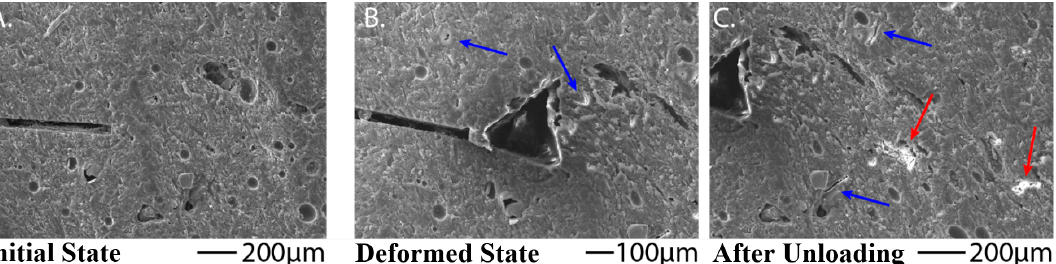
Figure 8. In situ images of an ENF specimen of ( A ) the crack tip region prior to loading; ( B , C ) the deformed crack tip region.